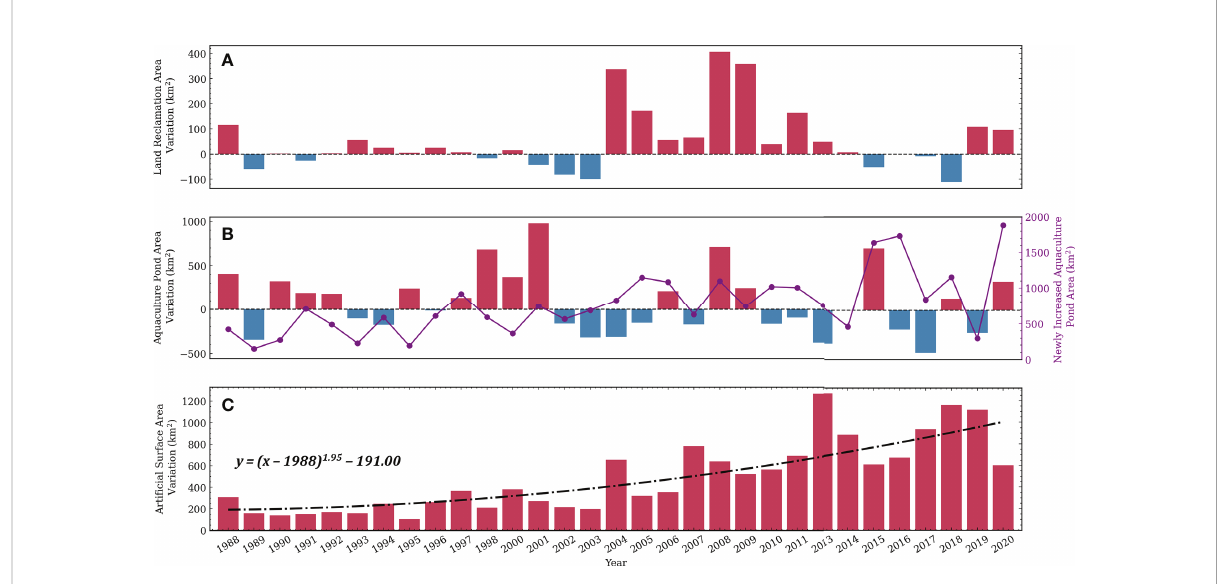
FIGURE 4 Analysis on the area changes of (A) reclamation, (B) aquaculture ponds, and (C) arti fi cial surface in the Circum-Bohai Coastal Zone from 1990 to